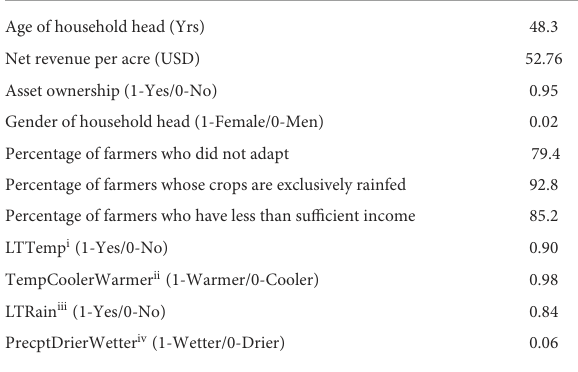
TABLE 1 Summary statistics of key